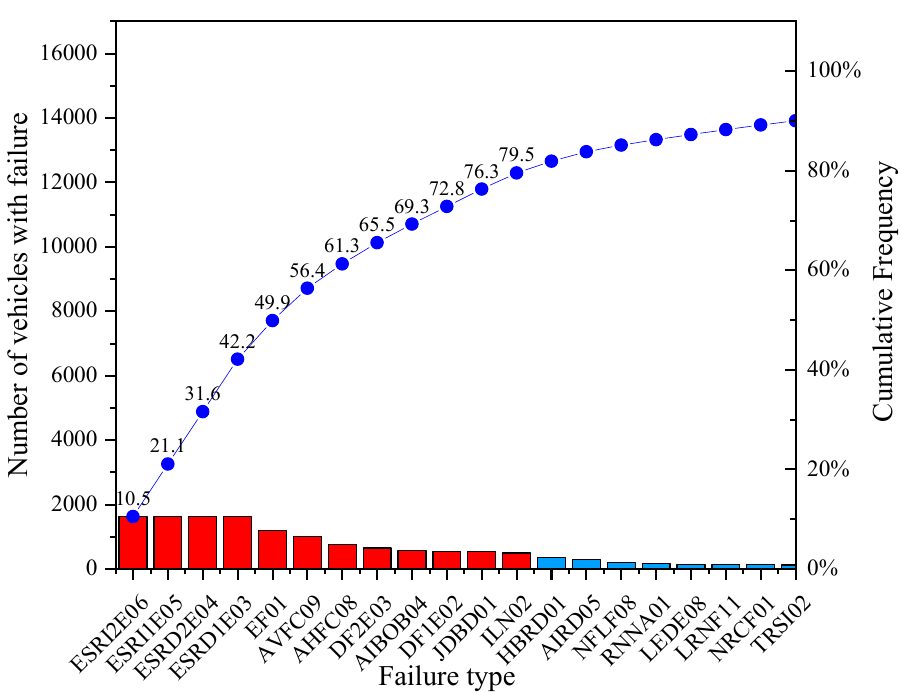
Figure 7. VTI representative failures for subcategory M3 bus type.